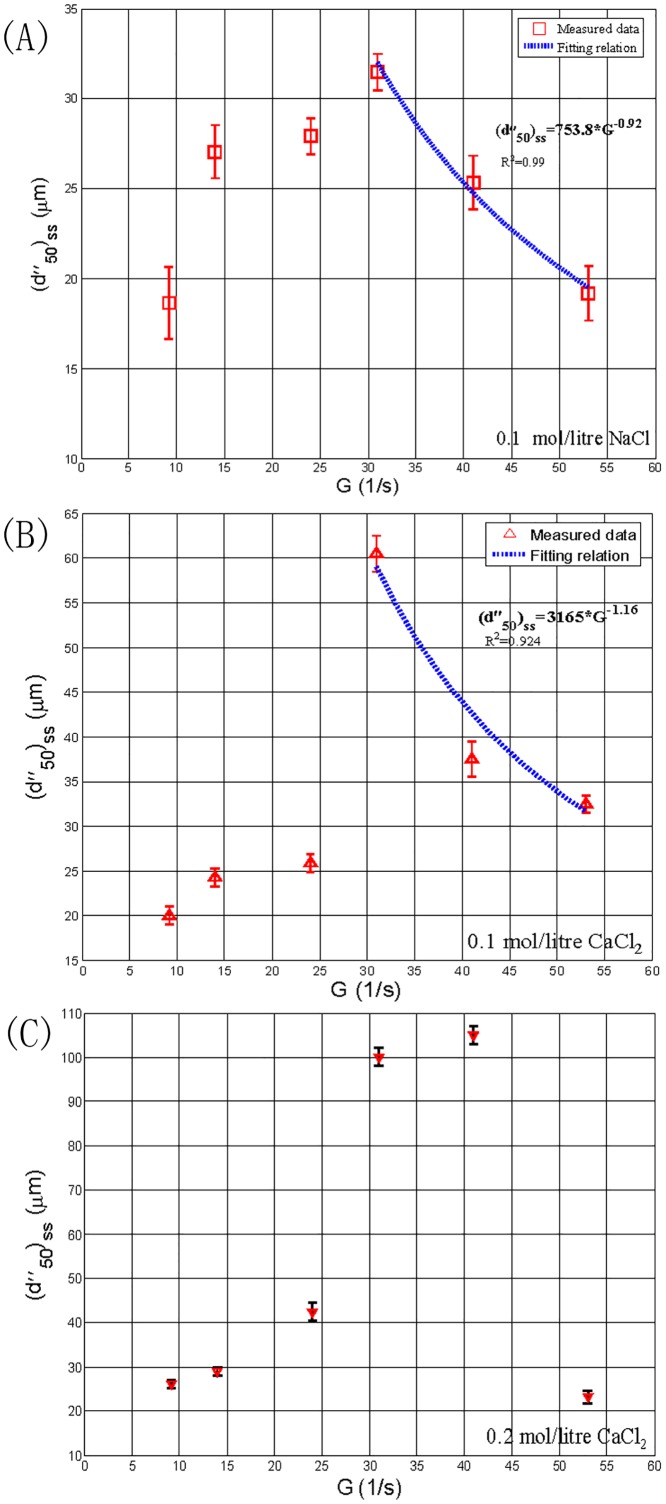
The steady-state median floc size with respect to six shear rates, with 0.1mol/litre NaCl (A), 0.1mol/litre CaCl2 (B), and 0.2mol/litreCaCl2 (C) (ϕ = 7.87×10−5).The error bars in (A–C) show standard deviations of the median floc size calculated from the floc size distribution.